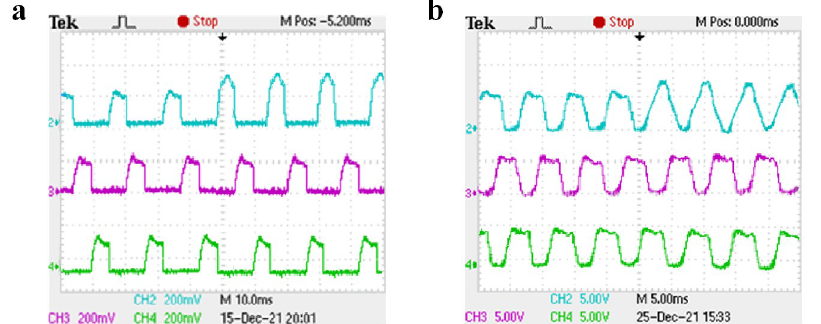
Fig 18. The short-circuit fault of A-phase SA1 experimental waveform. (a) The speed is 500 r/min. (b) The speed is 1000 r/min.